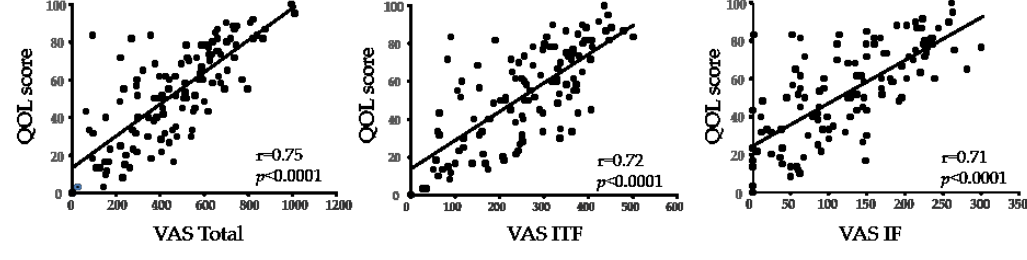
Figure 4. Correlation between VAS score and QOL score in DE. “r” indicates the Spearman correlation coefficient. ITF, instability of tear film; IF, increased friction; R, reflex; DTC, delayed tear clearance. Table 2. Correlation between QOL score and VAS score.